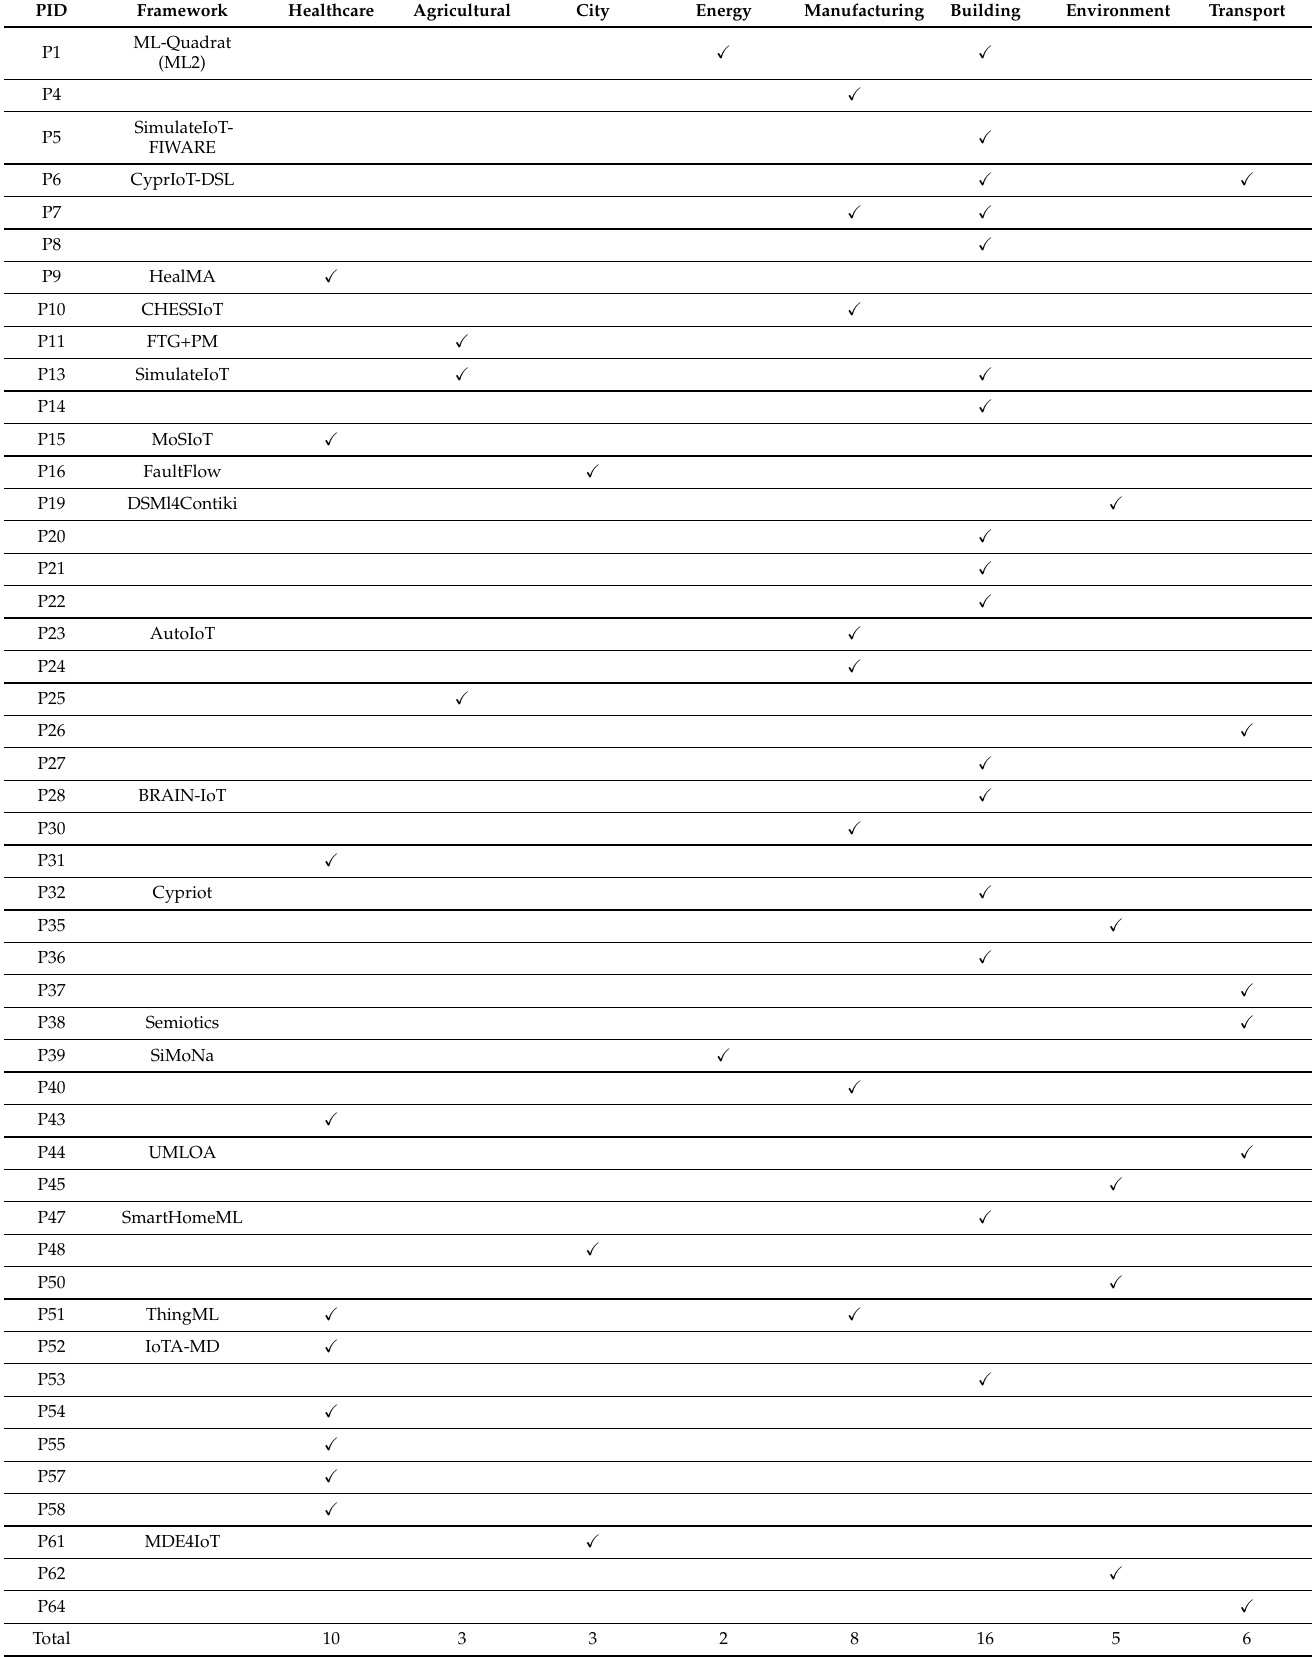
Table 5. Distribution of papers by application